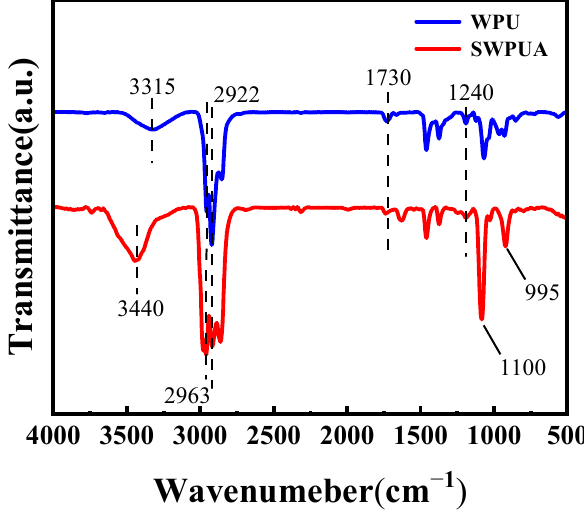
Figure 3. FT-IR spectra of WPU and SWPUA. Compared with the spectra of WPU, it can be found that the absorption peak of Si-C stretching vibration appeared at 995 cm − 1 in the spectra of SWPUA, and the absorption peak at 1240 cm − 1 was enhanced and broadened, indicating that in addition to the C-O-C stretching vibration, a Si-O stretching vibration also appeared, and the characteristic absorption peak of C=C disappeared at 3000–3100 cm − 1 , which indicated that free radical polymerization has occurred and the double bond had completely reacted, i.e., the silane coupling agent had been successfully introduced to the WPUA chain segment and the SWPUA emulsion had been prepared successfully [29]. In addition, it can be seen in the infrared spectrogram of SWPUA that stretching vibration absorption peak of Si-O-Si appeared at 1100 cm − 1 , which indicates the hydrolysis of alkoxy group in silane coupling agent A172. The organosilanol was produced because of the hydrolysis of the silane coupling agent, which will not exist stably, and it will further condense to generate siloxane bond